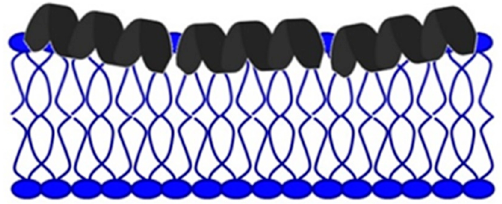
Figure 4. Carpet model.